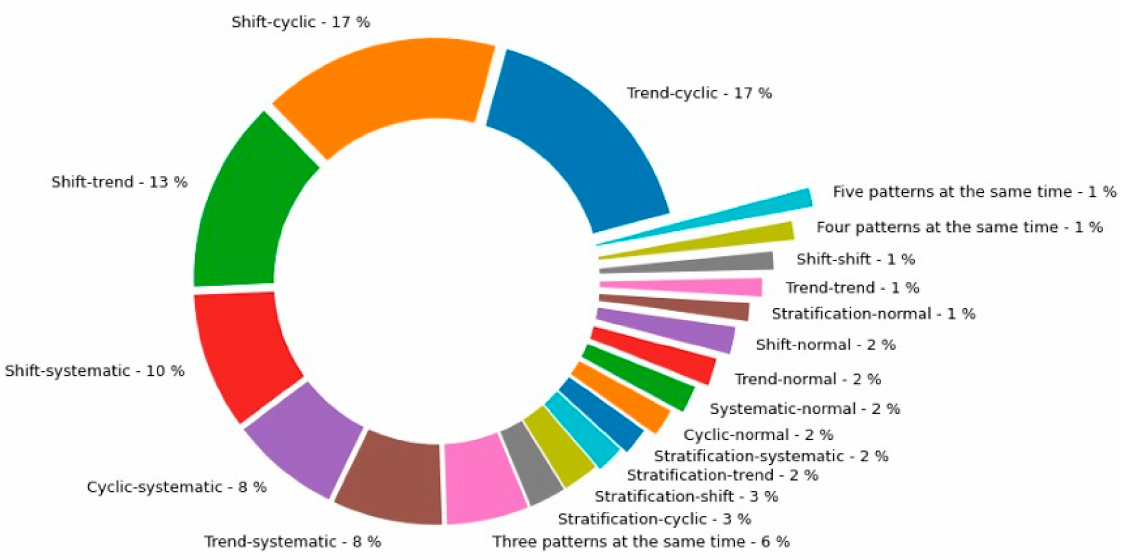
Figure 15. Breakdown of types of concurrent